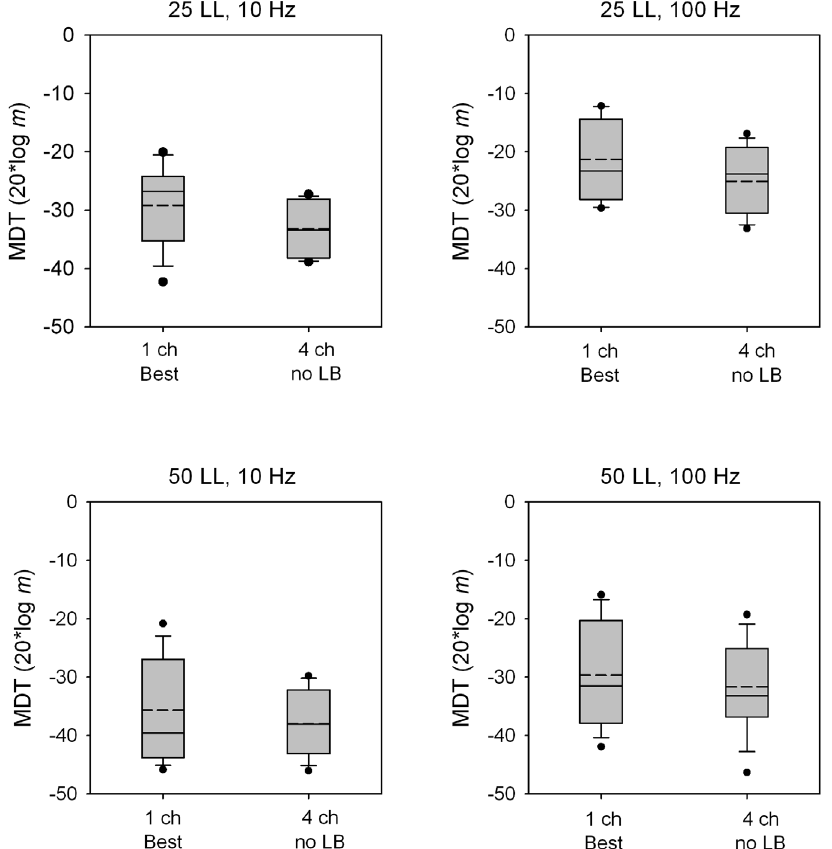
Figure 5. MDTs for single- and multi-channel stimuli without loudness summation compensation. Box plots are shown for MDTs with the best single-channel or with the 4-channel stimuli without loudness-balancing; note that the 4-channel stimuli without loudness-balancing were louder than the single-channel stimuli. From left to right, the panels show data for the 25 LL/10 Hz, 25 LL/100 Hz, 50 LL/10 Hz, 50 LL/100 Hz conditions. In each box, the solid line shows the median, the dashed line shows the mean, the error bars show the 10 th and 90 th percentiles, and the black circles show outliers.